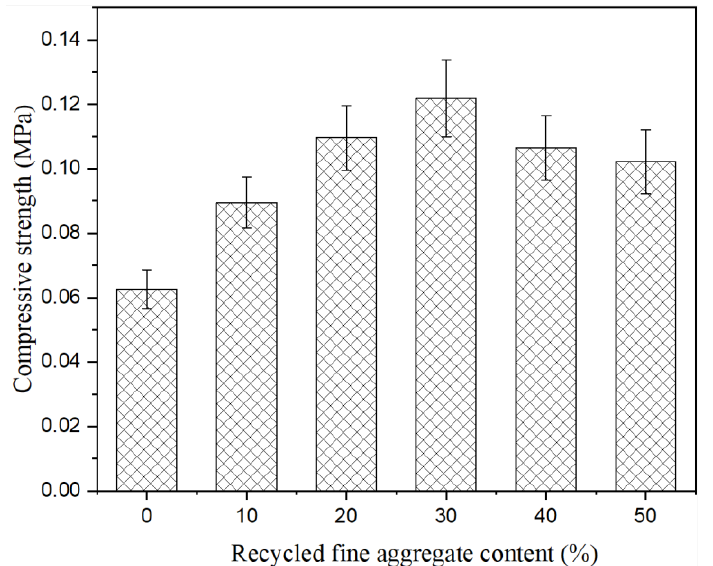
Figure 2. Compressive strength of soft soil solidified without composite solidification agent.